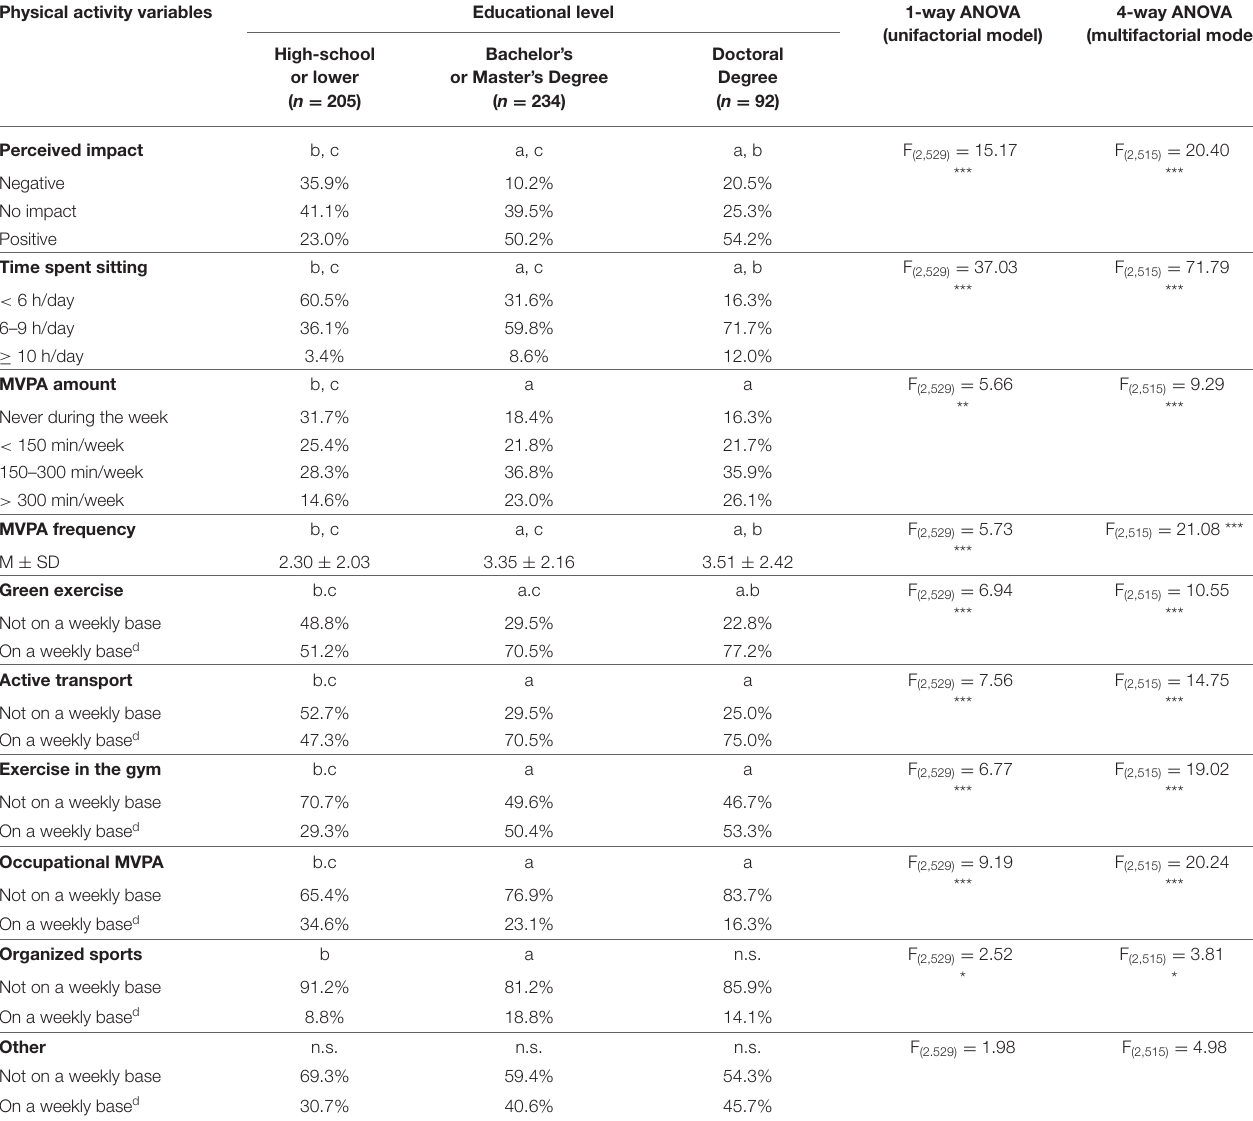
TABLE 6 | Physical activity profile of Italian immigrants in Norway, by educational level ( n = 531). Physical activity